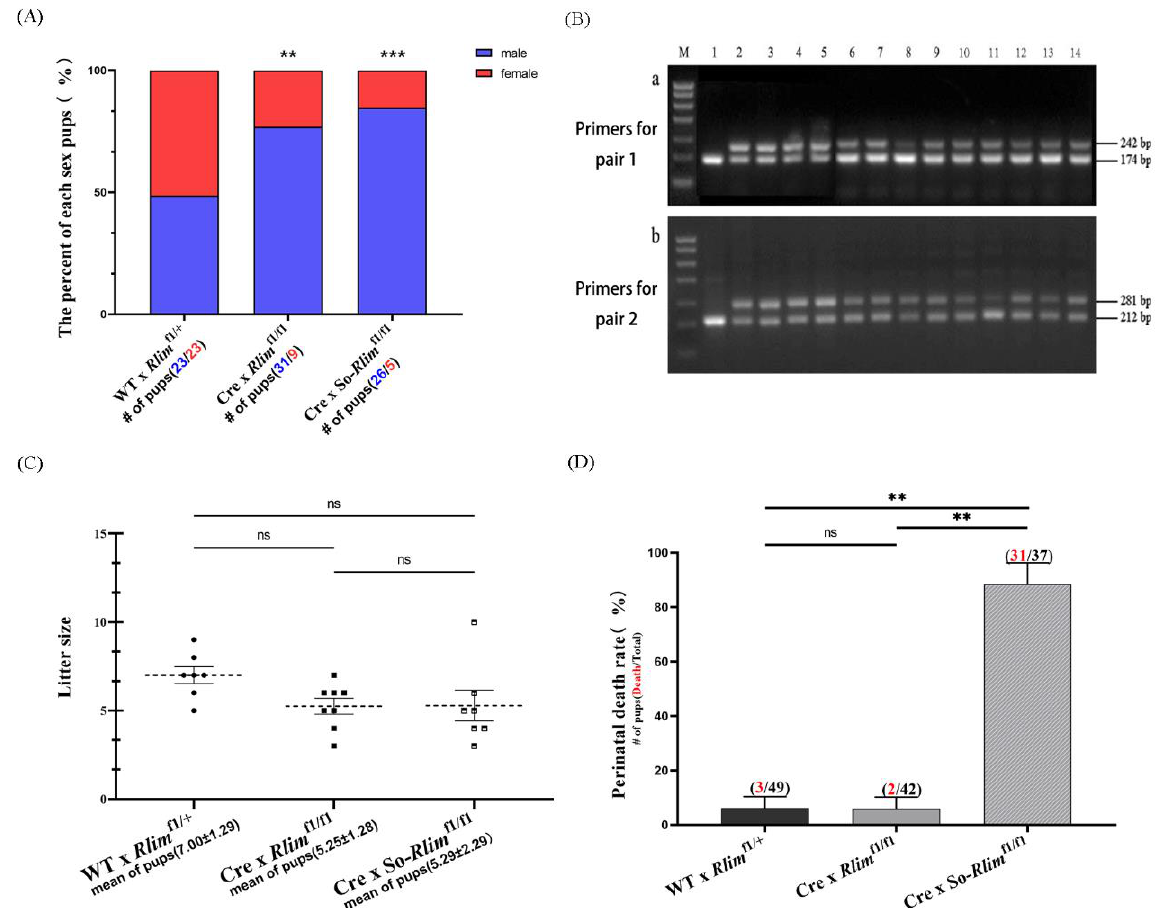
Figure 5. Effects of superovulation in the mother mice and maternal Rlim allele knockout in the embryos on the sex ratio of offspring, litter size and perinatal motility of the offspring. ( A ) Effects of knocking out the embryo’s maternal Rlim allele on the sex ratio of born offspring. When the transgenic father mice carry an X-linked Cre-enzyme gene and the homozygous Rlim fl/fl transgenic mother mice mate, the maternal Rlim allele is knocked out in the female embryos. ( B ) Genotype identification of the 14 female-born offspring mice delivered by the homozygous Rlim fl/fl transgenic mother mice mated with the Cre-transgenic father mice. When amplifying the genomic DNA of the 14 female-born offspring mice using primers for pair 1 and primers for pair 2, since both primers F6 and R3 were located on the Rlim gene knockout region (see Figure 4A), the heterozygous Rlim KO/+ knockout female offspring mice (with a successful knockout of the maternal Rlim allele) will not show the 242 bp band and the 282 band, respectively. It will, however, show the 174 bp band and the 212 bp band, respectively. Heterozygous Rlim fl/+ transgenic female offspring mice (without successful knockout of the maternal Rlim allele) will show 242 bp and 174 pb bands, and 281 bp and 212 pb bands, respectively. ( C ) Effects of superovulation in the mother mice and knockout of the maternal Rlim allele in the embryos on litter size. ( D ) Effects of superovulation in the mother mice and knockout of the maternal Rlim allele in the embryos on the perinatal death rate of born progenies. The number of perinatal deaths was calculated by the number of stillborn pups and the number of pups that died within 3 days after birth. So represents superovulated Rlim fl/fl mother mice, ns represent nonsignificant difference at p > 0.05; ** and *** represent p < 0.01 and p < 0.001,